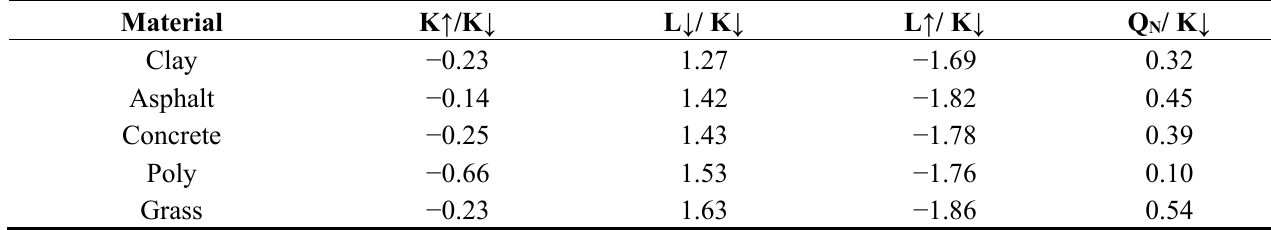
Table 5. Average of NR01 components divided by K ↓